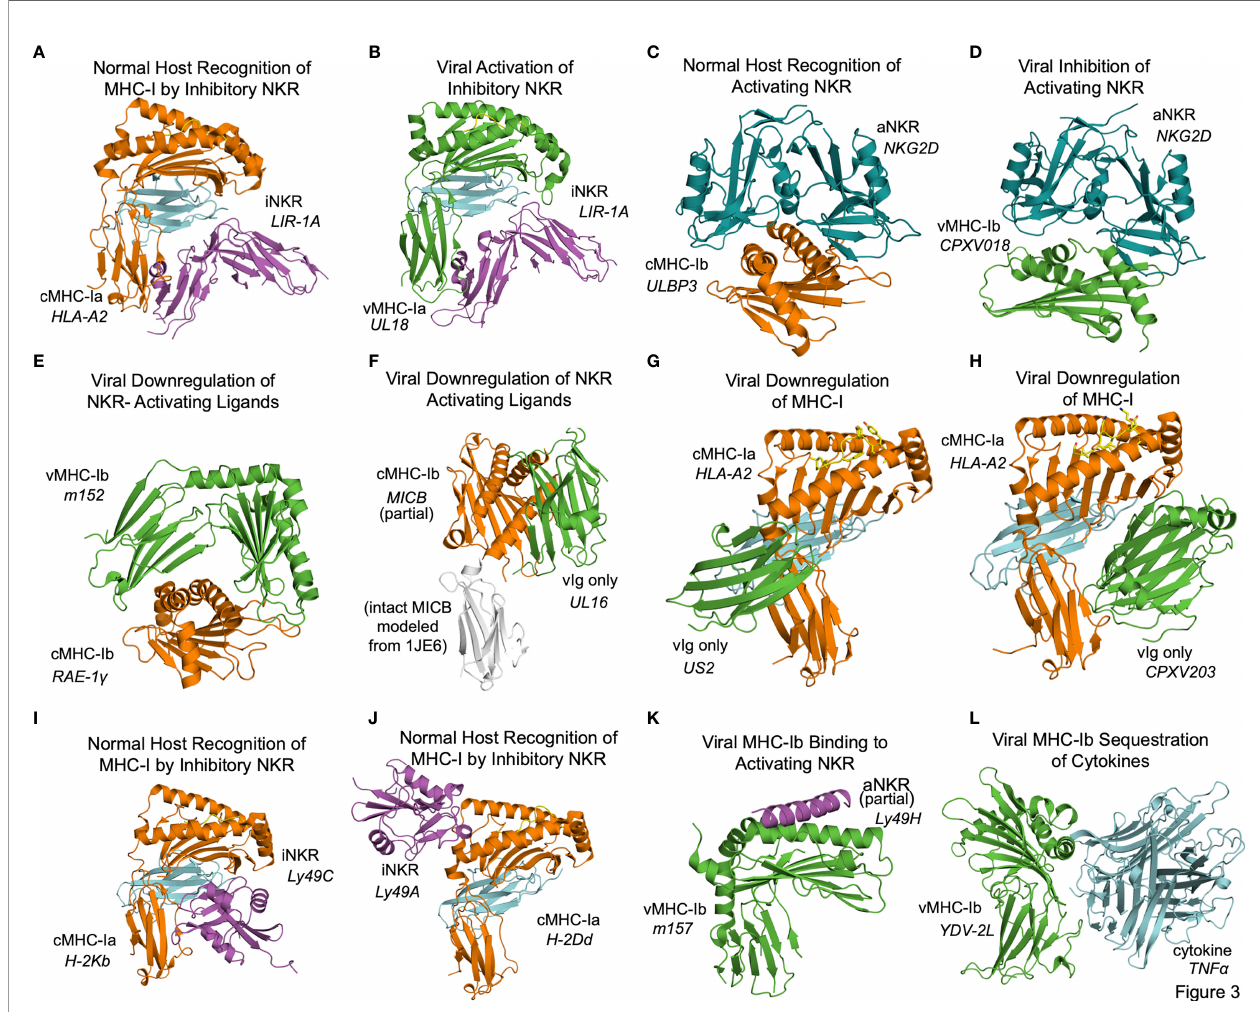
FIGURE 3 | Structural aspects of classical and non-classical MHC immunoevasion. Crystal structures of cMHC-I (orange) and vMHC-I (green) in complex with cellular binding partners ( Table 2 ). (A) cMHC-Ia protein HLA-A2 bound to inhibitory NKR LIR-1A (PDB: 1P7Q). (B) viral cMHC-Ia homolog UL18 from HCMV bound to inhibitory NKR LIR-1A (PDB: 3D2U). (C) cMHC-Ib ULBP3 bound to the activating NKR NKG2D (cyan) (PDB: 1KCG). (D) ULBP homolog CPXV018 from cowpox virus interacting with activating NKR NKG2D (cyan) (PDB: 4PDC). (E) m152, a vMHC-Ib protein bound to cMHC-Ib RAE-1 g , promoting retention and eventual degradation (PDB: 4G59). (F) vMHC-Ib UL16 from HCMV bound to cMHC-Ib MICB (PDB: 2WY3 and 1JE6). (G) Viral Ig-domain protein US2 from HCMV binding cMHC-Ia HLA-A2, targeting it for degradation (PDB: 1IM3). (H) Viral Ig-domain protein CPXV203 from cowpox virus binding cMHC-Ia HLA-A2, targeting it for degradation (PDB: 4HKJ). (I) cMHC-Ia protein H-2Kb bound to inhibitory NKR Ly49C (38CK). (J) cMHC-Ia protein H-2Dd bound to inhibitory NKR Ly49A (PDB: 1QO3). (K) vMHC-Ib m157 from HCMV interacting with activating NKR Ly49H (PDB: 4JO8). (L) vMHC-Ib 2L protein from YDL virus interacting with cytokine TNF a